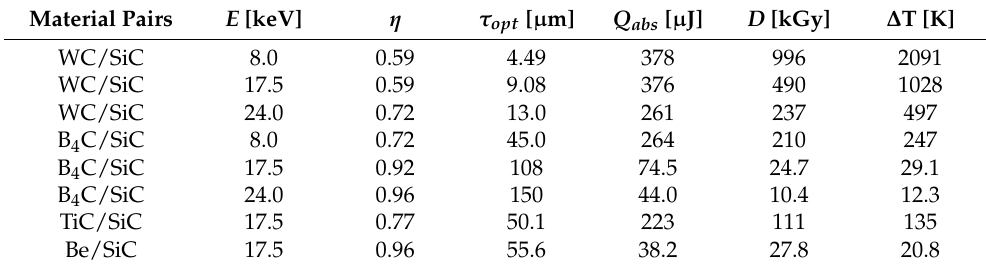
Table 2. Focusing efficiency η , optimum thickness τ opt , absorbed energy Q abs , dose D , and instanta- neous temperature rise ∆ T in MLLs for an incident beam energy of 1 mJ in an area of (100 µ m) 2 at photon energy E